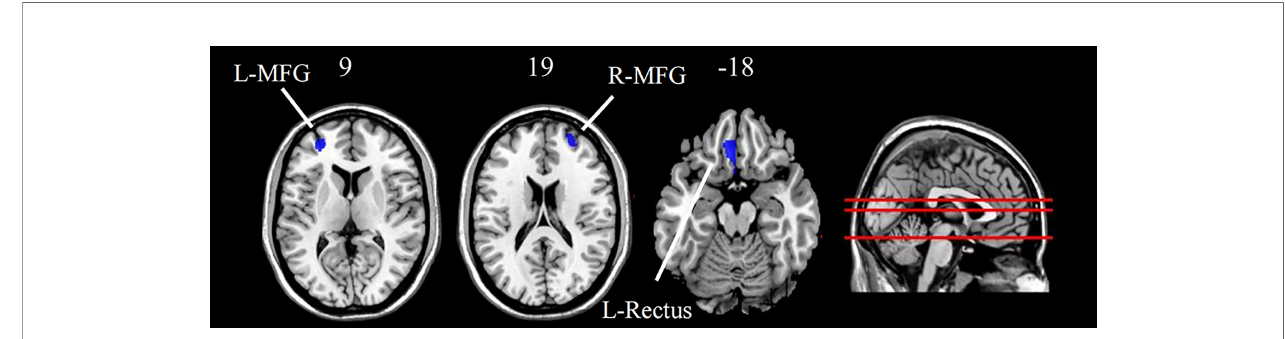
FIGURE 1 | Group difference of grey matter density between MDD patients and HC (FWE cluster-level corrected, p < 0.05). Images are displayed in neurological orientation (left is left) with MNI z axis coordinated. L, left; R, right; L-MFG, left middle frontal gyrus; R-MFG, right middle frontal gyrus; L-Rectus,